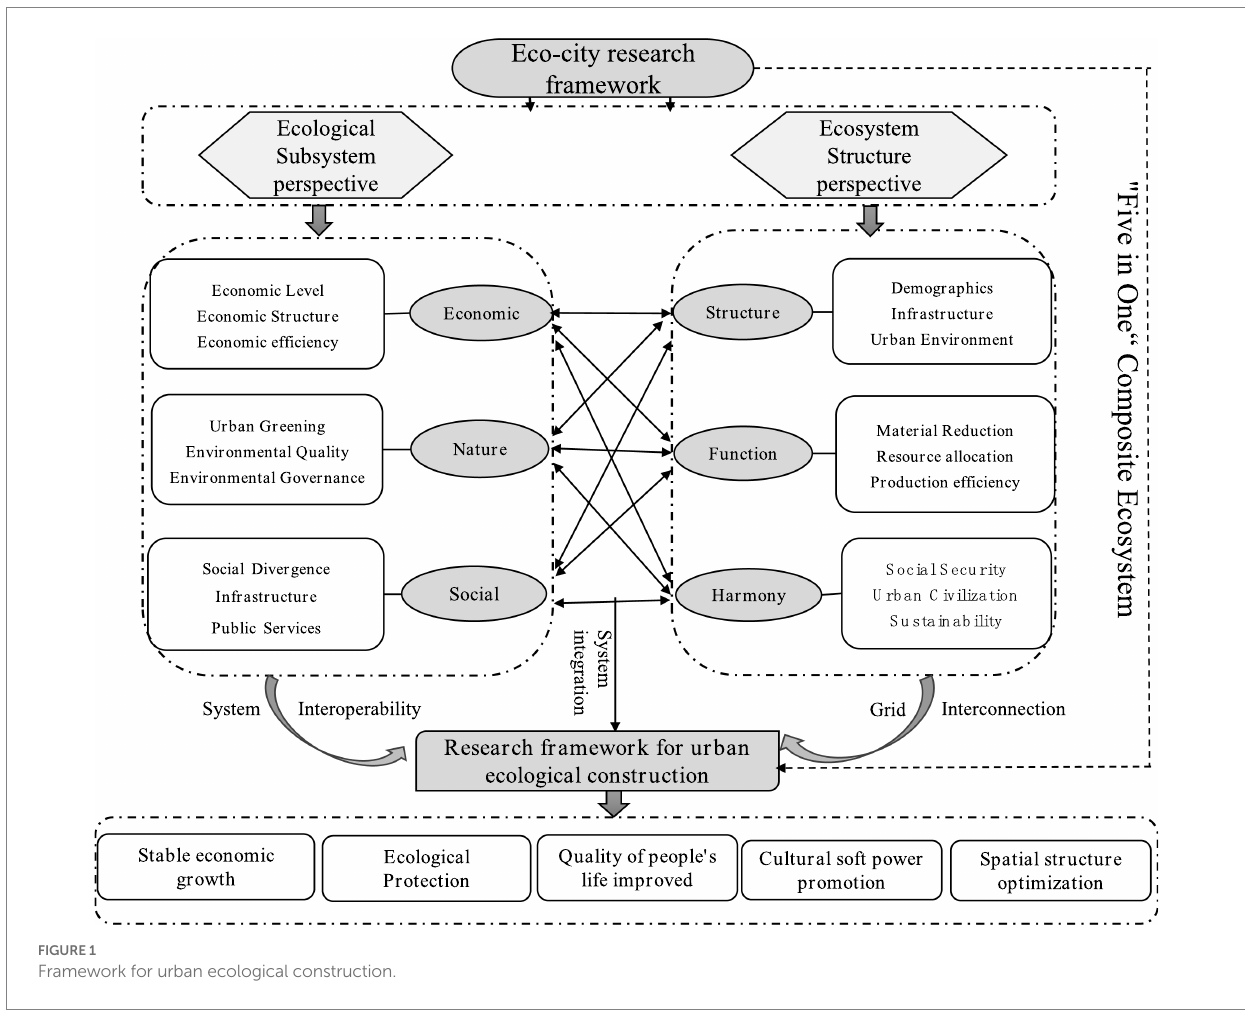
FIGURE 1 Framework for urban ecological